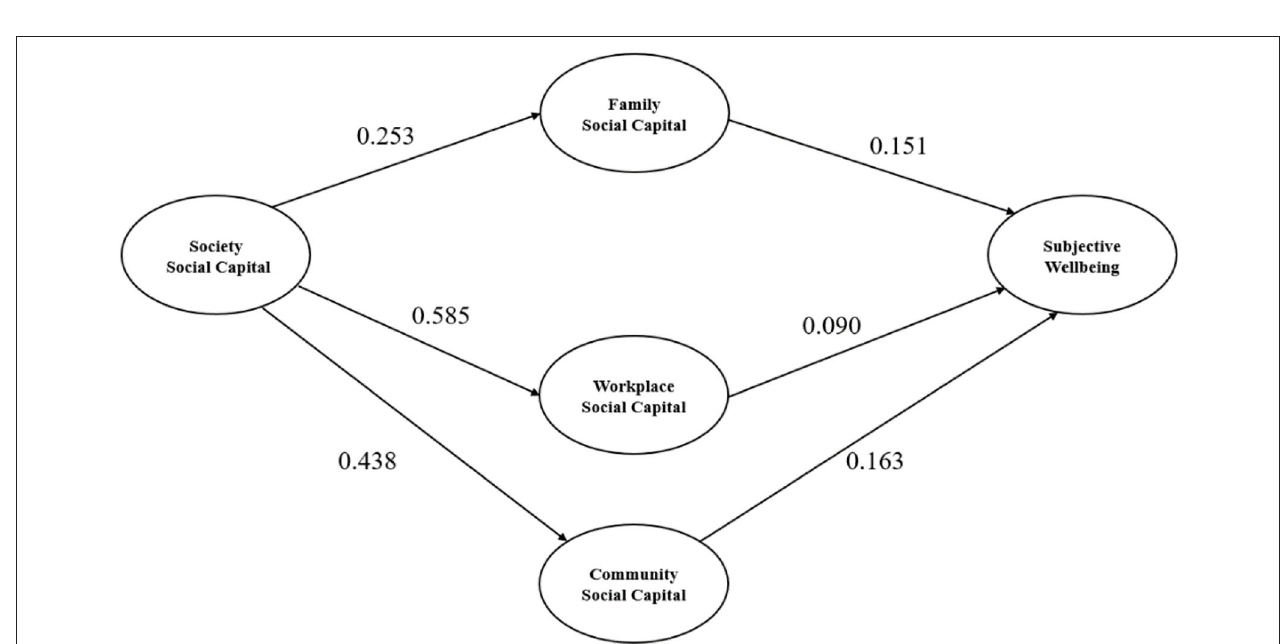
FIGURE 2 | The final model and standardized model